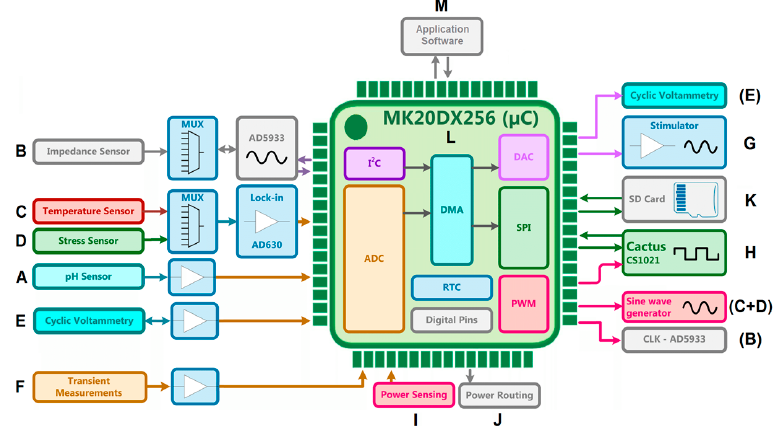
Figure 1. Block diagram of the MUlti-SEnsor array (MUSE) system composed of the following functional modules: A—pH sensor; B—impedance sensor; C—temperature sensor; D—stress sensor;